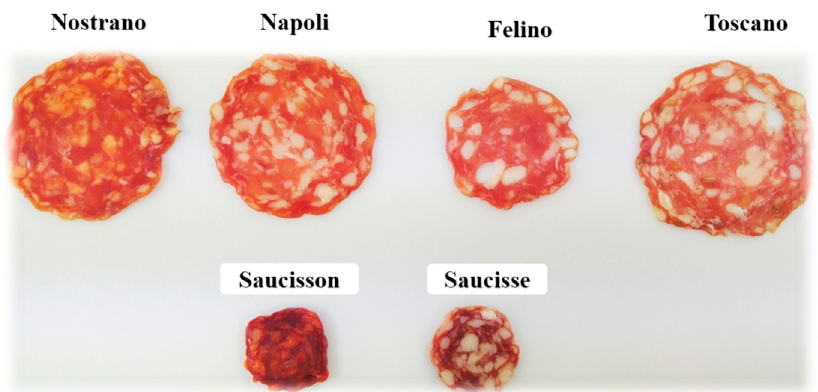
Figure 1. Photos of six examples of pre-sliced commercial fermented salami from China. Nos and Nap are produced by Yuran, Fel and Tos by Casa Modena, and Sse and Sau by Bastides. Retail packs of each salami (90–100 g each) were used in China for tasting by the consumer discussion group and additional packs were imported to New Zealand, where they were stored at 4 ◦ C (up to 1 month) prior to analysis. Four packs of each salami were used for assessment. Replication for each analysis was generally 2–6 slices per pack. Information on the products’ ingredients and starter cultures was provided by the manufacturers and is summarised in Table